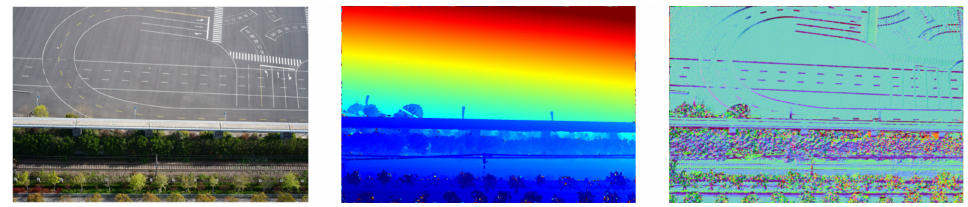
Figure 10. The original image and depth image and normal image of one picture.